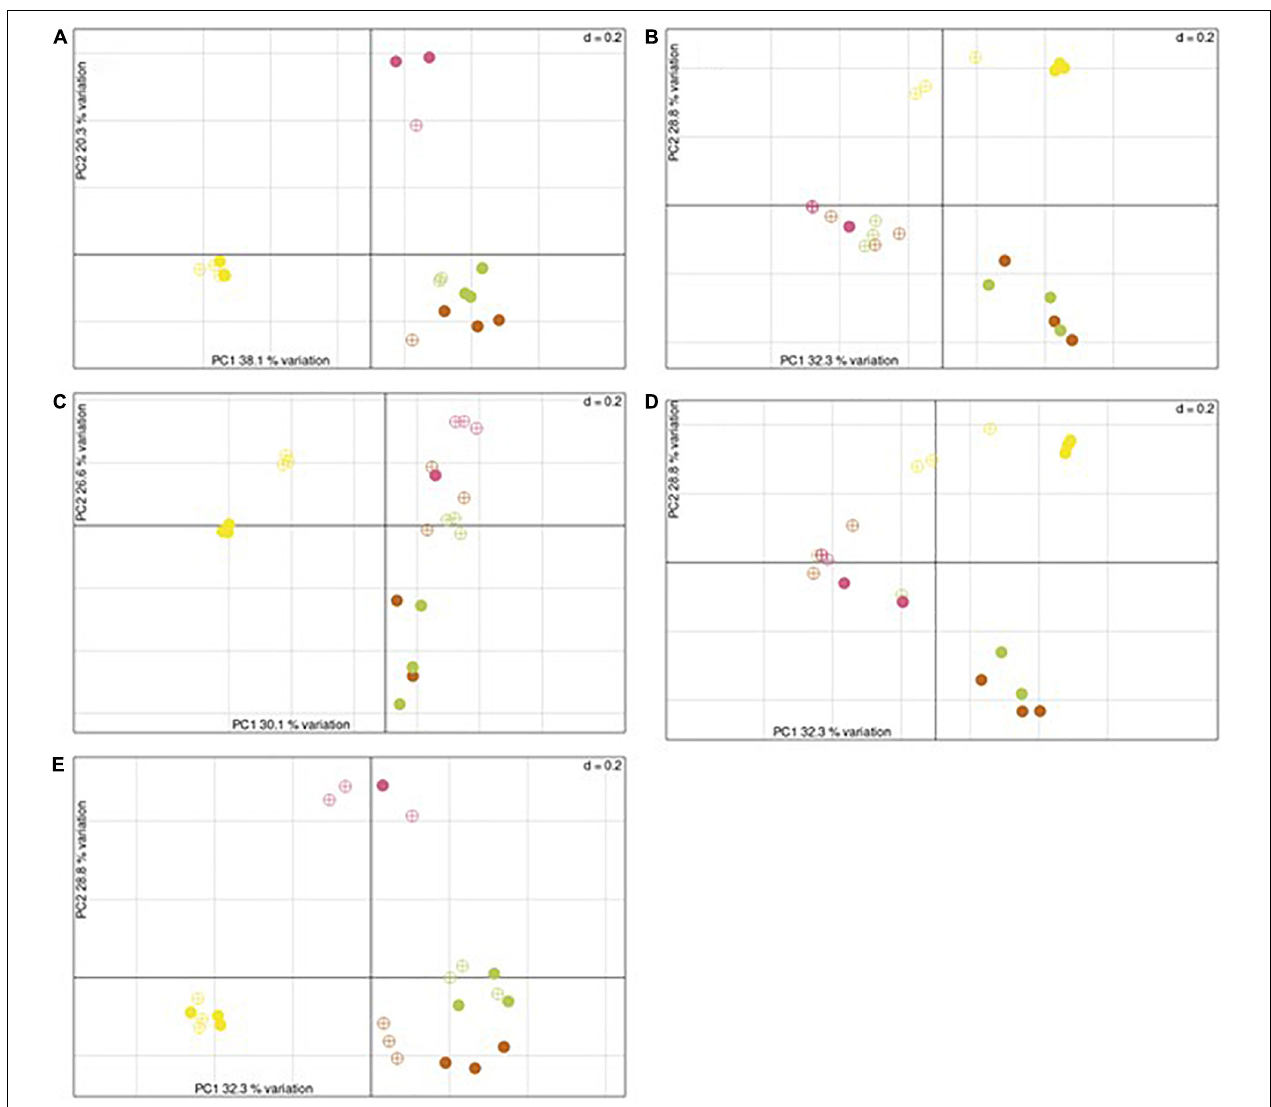
FIGURE 4 | Multidimensional scaling plots based on Bray–Curtis dissimilarity index for each primer set (A–E) . Colors indicate the four locations as proxy for the different macrobenthic communities as shown in Figure 1 , full circles indicate bulk DNA and open circles eDNA samples from the ethanol